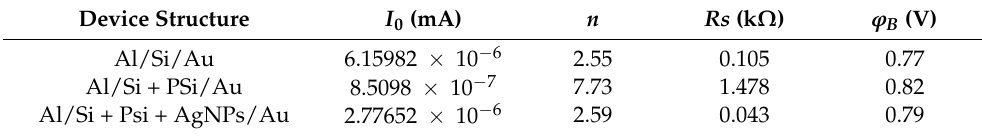
Table 1. DC electrical parameters obtained from the fitting of the experimental I–V